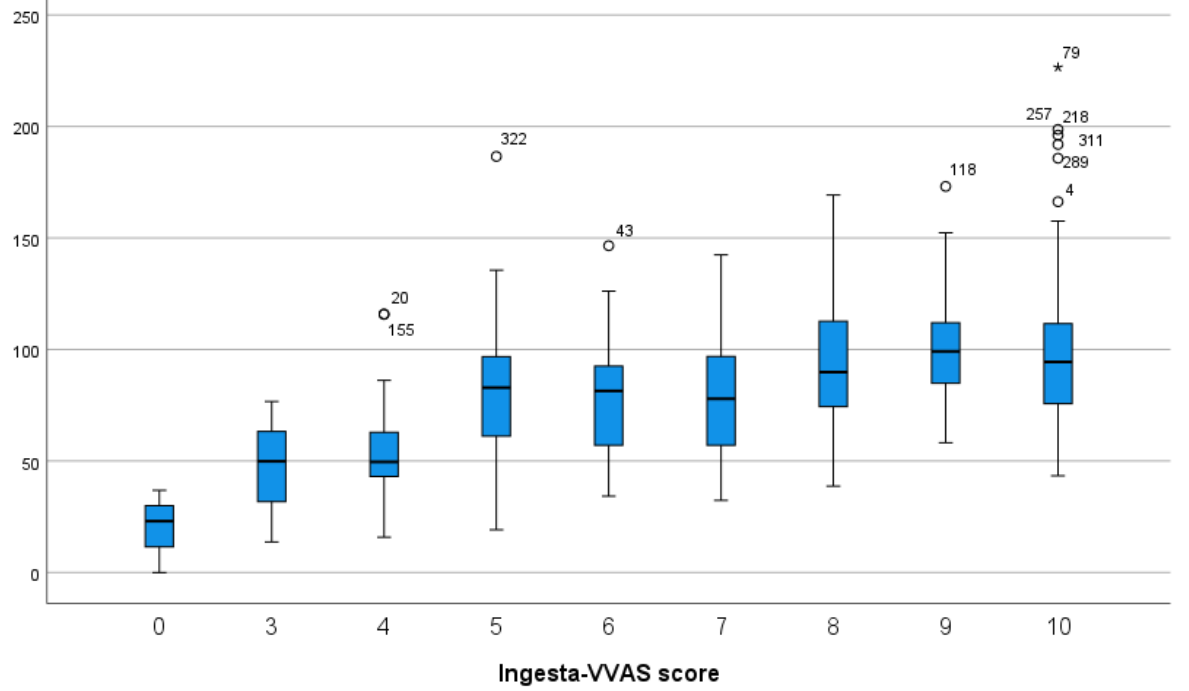
Figure 2. Association ( n = 322) between the Ingesta-Verbal/Visual Analogue Scale (ingesta-VVAS) and energy intake, calculated by a 24-h recall and expressed as percentage of Total Energy Expenditure (TEE), calculated by the World Health Organization 1985 formula [21] (BMI ≤ 30 kg/m 2 ) or Harris & Benedict 1918 formula [23] (BMI > 30 kg/m 2 ), both with an addition of 30% for physical activity/disease activity. BMI, body mass index. o outlier (3rd quartile + 1.5* interquartile range). * outlier (3rd quartile + 3* interquartile range).